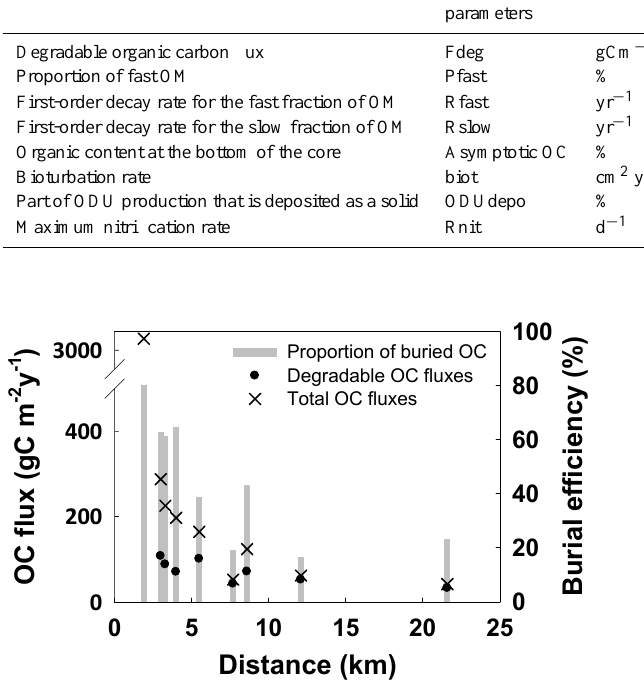
Figure 4 Flux of degraded (cid:122) and total × organic carbon (OC) together with burial efficiency as a Fig. 4. Flux of degraded • and total x organic carbon (OC) together function of distance from the Rhône River outlet. with burial efficiency as a function of distance from the Rhˆone River